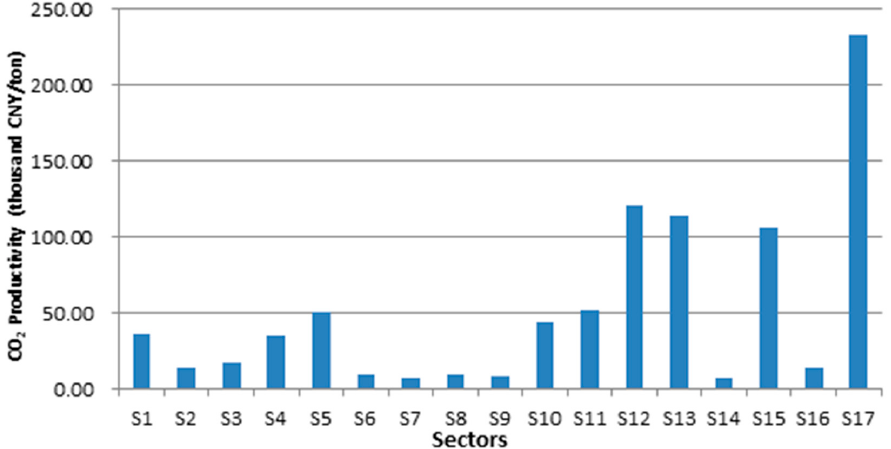
Figure A1. Mean values of CO 2 productivity of China’s 17 sectors in 2010.